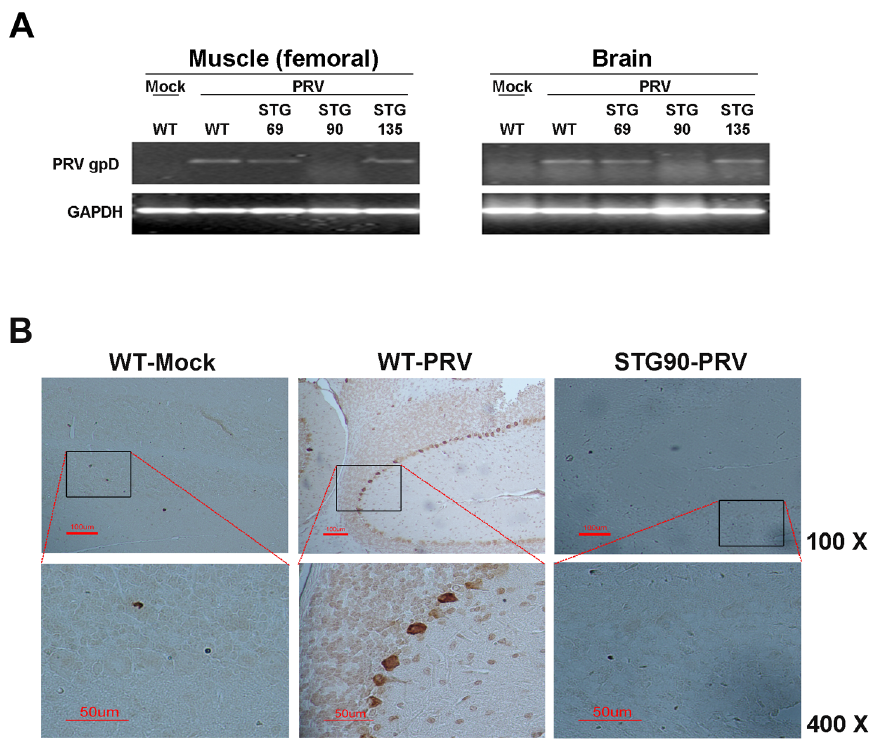
Figure 8. STG90 exhibits antiviral effects against PRV. A . The expression levels of PRV gpD RNA in the muscle and brain of WT-Mock, WT-PRV, STG69-PRV, STG90-PRV, and STG135-PRV mice were investigated. Only live STG90-PRV mice did not show PRV gpD expression. B . Immunohistochemistry was performed to detect PRV in PRV target organs; brain (upper panel: 6 100) and femoral muscle (bottom panel: 6 400). The PRV gpD protein was stained with a monoclonal anti-PRV antibody and visualized with DAB. The Purkinje layer cells in the WT-PRV group stained brown for the gpD protein, whereas no staining was observed in the other groups.